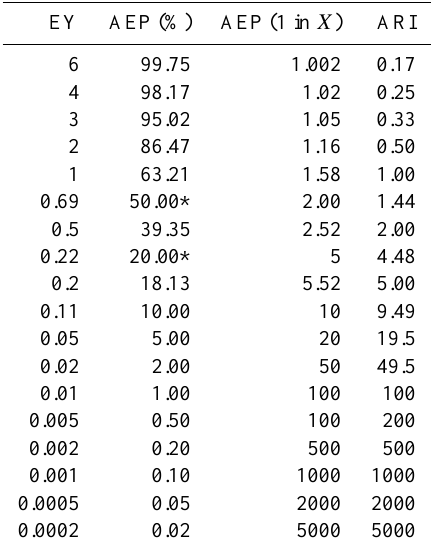
Table 1. ARI, AEP and EY